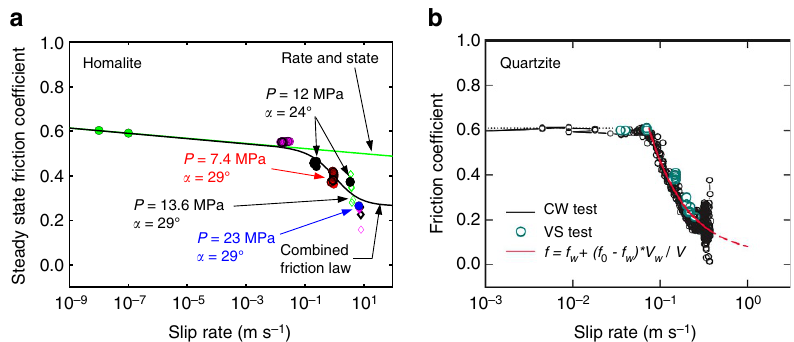
Figure 8 | Steady-state friction versus slip rate. ( a ) Experimental measurements of steady-state friction coefficient versus slip rate and fits with the standard rate-and-state friction formulation (green curve), and combined formulation of rate-and-state friction enhanced by flash heating (black curve). Our steady-state measurements are consistent with the combined formulation. Green dots are low-velocity measurements obtained in collaboration with Kilgore, Beeler, and Lu and reported in Lu 39 . Red, blue, black and purple solid symbols are measurements obtained with the smallest field of view used in this study (18 (cid:3) 11.2mm 2 ) and hence the highest level of accuracy. The green, black and purple empty diamonds are measurements with larger fields of view (up to 145 (cid:3) 91mm 2 ) and lower levels of accuracy. ( b ) Experimental measurements of dynamic friction on quartzite samples 22 , showing similar behaviour for rocks, with significant slip-rate dependence of friction for high steady-state slip rates, consistent with the flash heating formulation. Note the different horizontal scale for the two